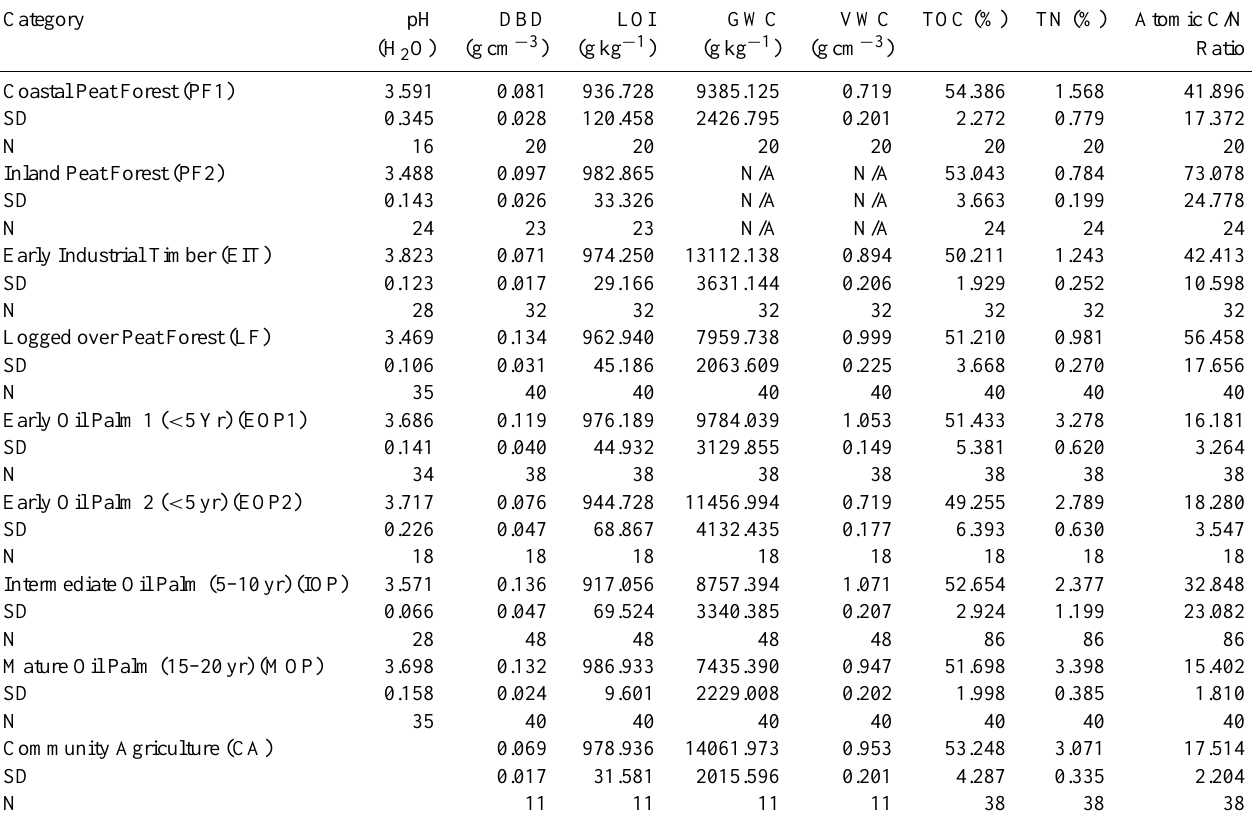
Table 12. Means of Research Variables according to Land Use Groups.